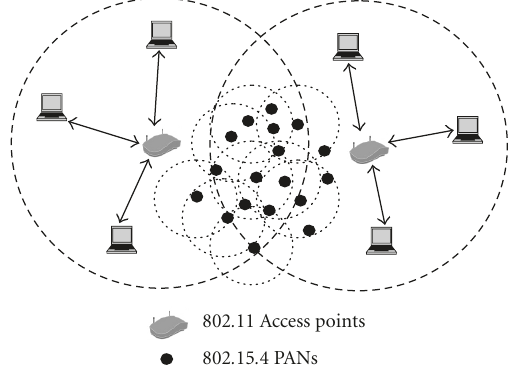
Figure 1: An example in which spectrum-agility would be ben- eficial: 802.11 nodes communicating to an AP and 802.15.4 PAN around their coordinators.